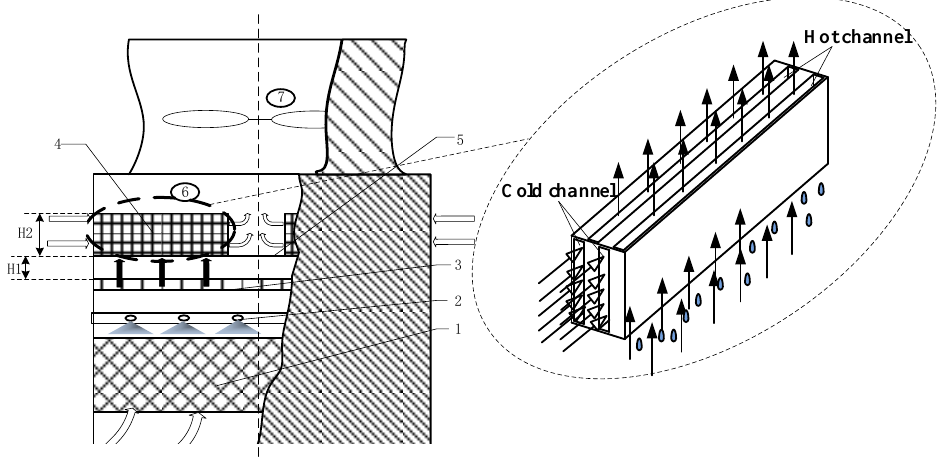
Figure 3. Vapor-condensing plume abatement device for the confined space cooling towers (CSCTs). 1, Fill; 2, Sprinkler; 3, Water collector; 4, Condenser; 5, Baffle; 6, Transition chamber; 7, Fan.